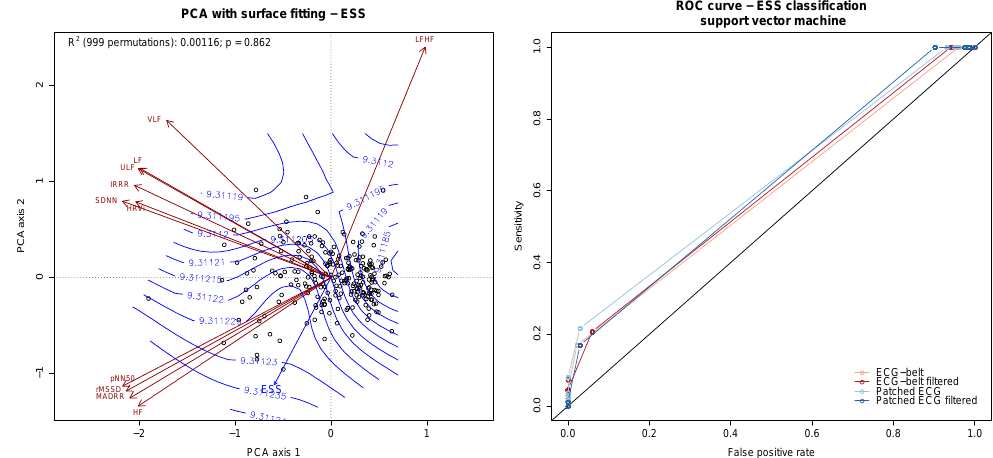
Figure 3. Predictive and diagnostic accuracy of the HRV features with regards to AHI, ODI and ESS. The predictive accuracy of the HRV features is provided by surface fitting applied to PCA ( left panels ). The isoclines (blue lines) superimposed to the PCA biplot display the linear relationship (trend surface) between HRV features and the responses (AHI, ODI, ESS; blue arrows). The diagnostic accuracy is shown by means of ROC curve displaying the sensitivity vs. false positive rate of a support vector machine-based AHI classifier ( right panels ). The curves are derived from ECG data obtained during PSG and ECG belt with or without data pre-filtering. The diagonal line indicates the random guess line. The dotted lines of the upper right panel cross at the optimal classification accuracy for AHI (AHI = 18 h − 1